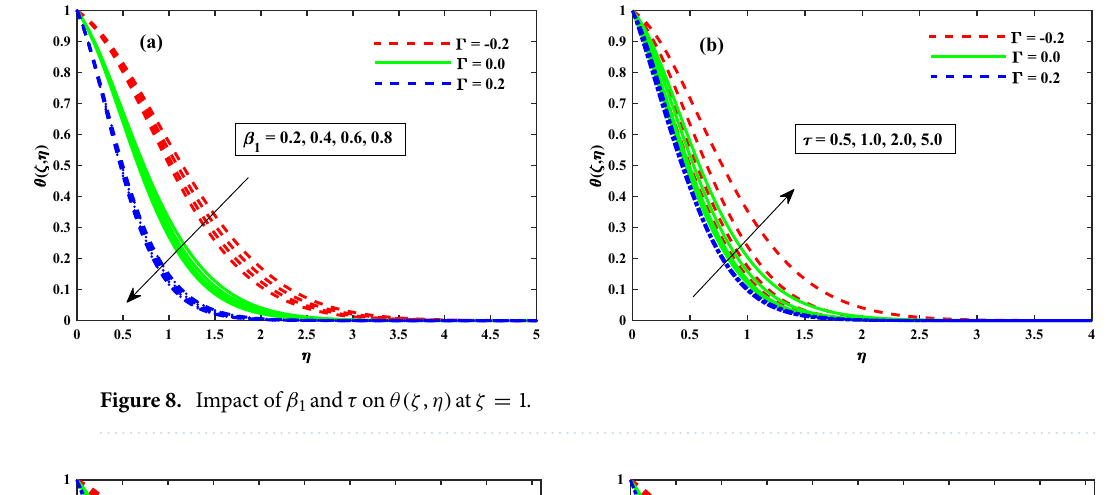
1 / 2 y in y-direction.